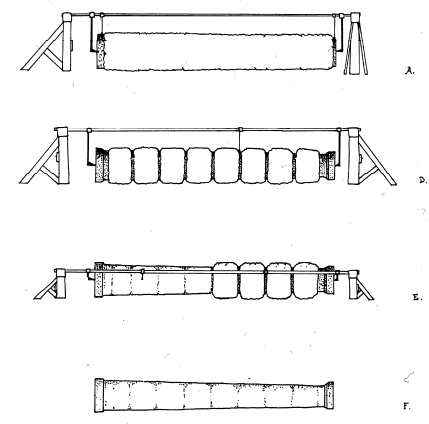
Figure 7. A type of the procedure of processing of a column Observing the sectional shape and the chisel marks gives us the